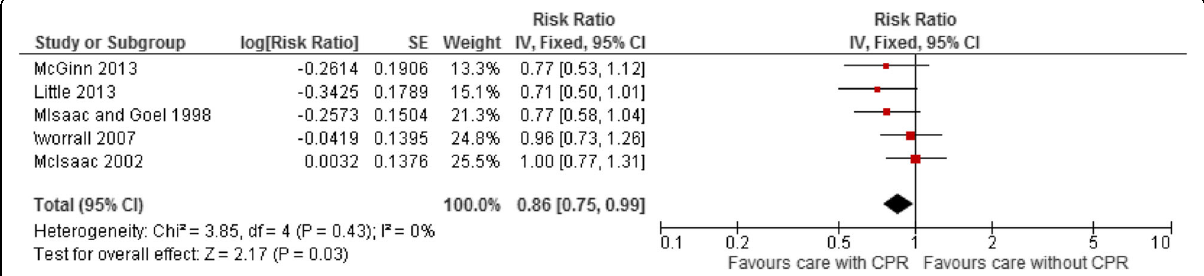
Fig. 3 Meta-analysis of Group A Streptococcus throat infection studies for the outcome antibiotic